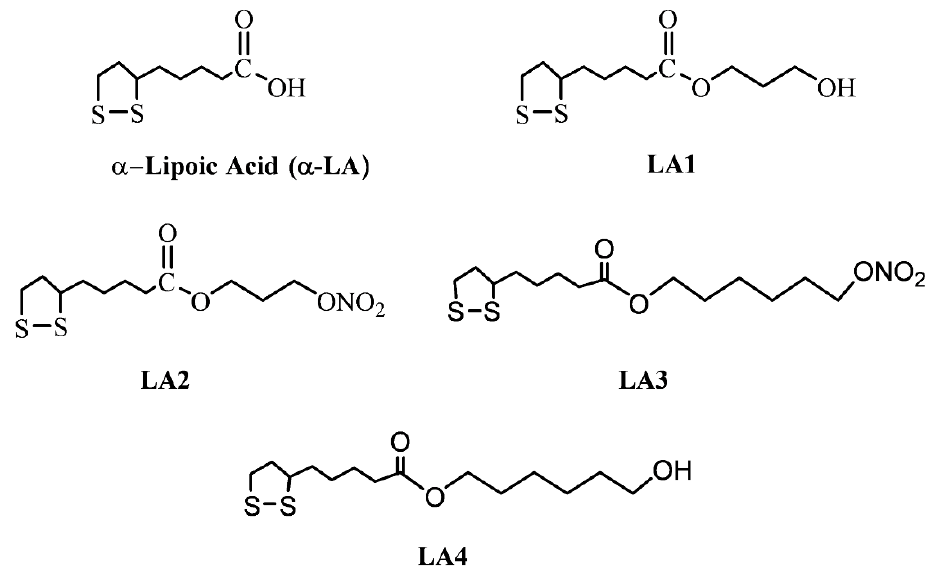
Figure 1. Chemical structure of α -Lipoic acid and its derivatives.